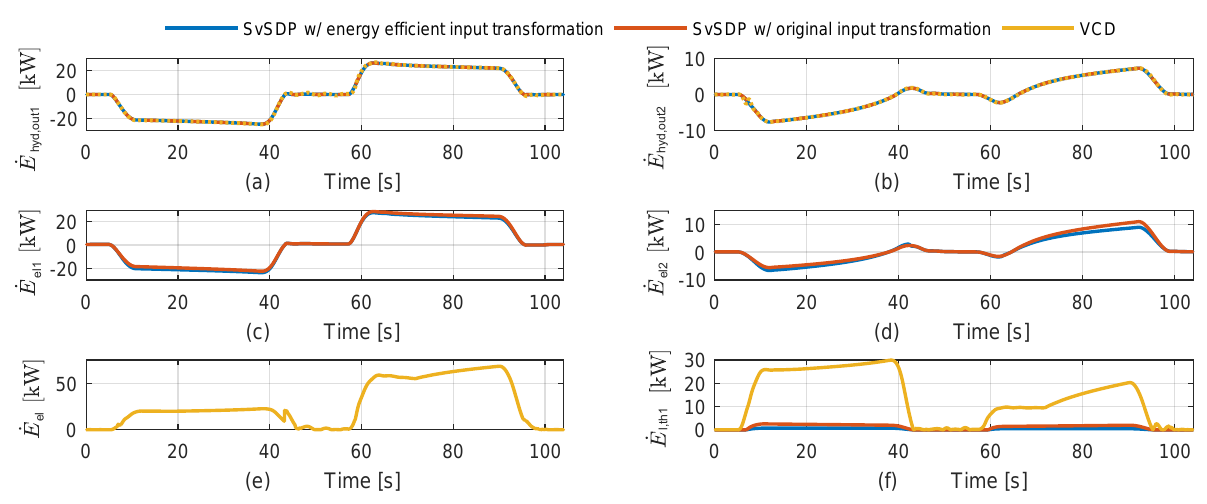
Figure 16: (a) Hydraulic output power cylinder 1. (b) Hydraulic output power cylinder 1. (c) Electrical input power SvSDP 1 . (d) Electrical input power SvSDP 2 . (e) Electrical input power VCD, common